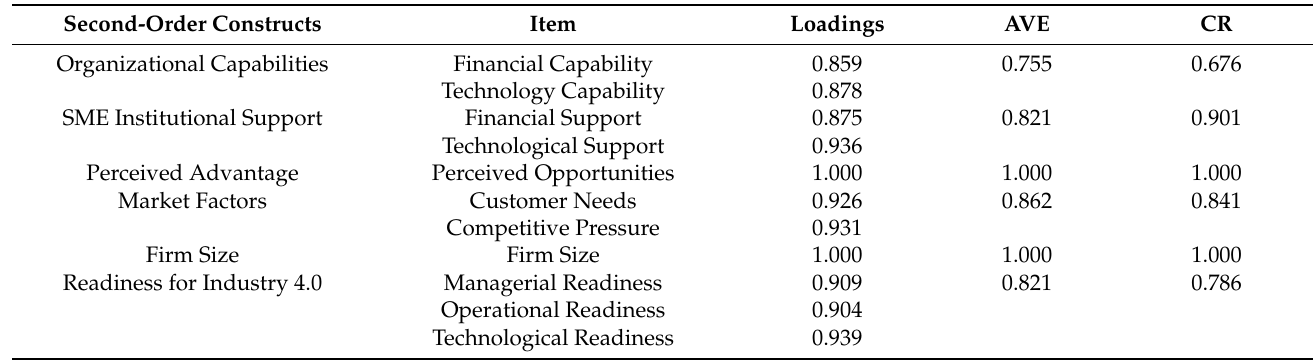
Table 10. Measurement model for the second-order